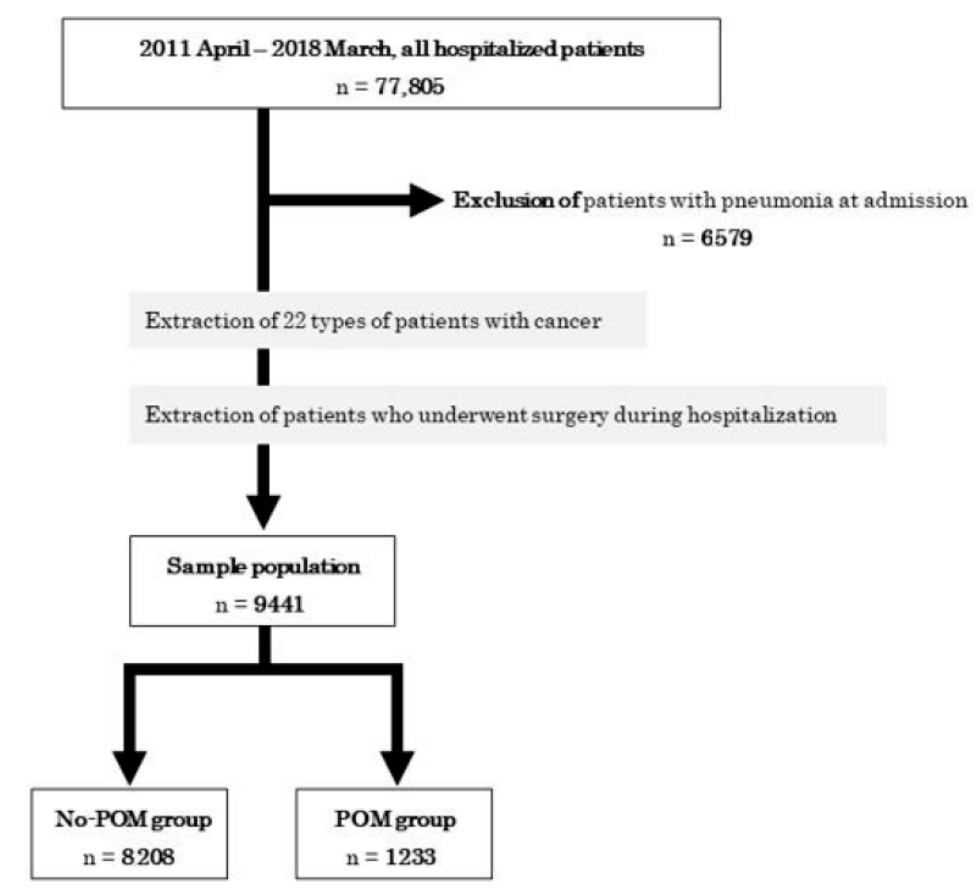
Figure 1. Scheme of patient